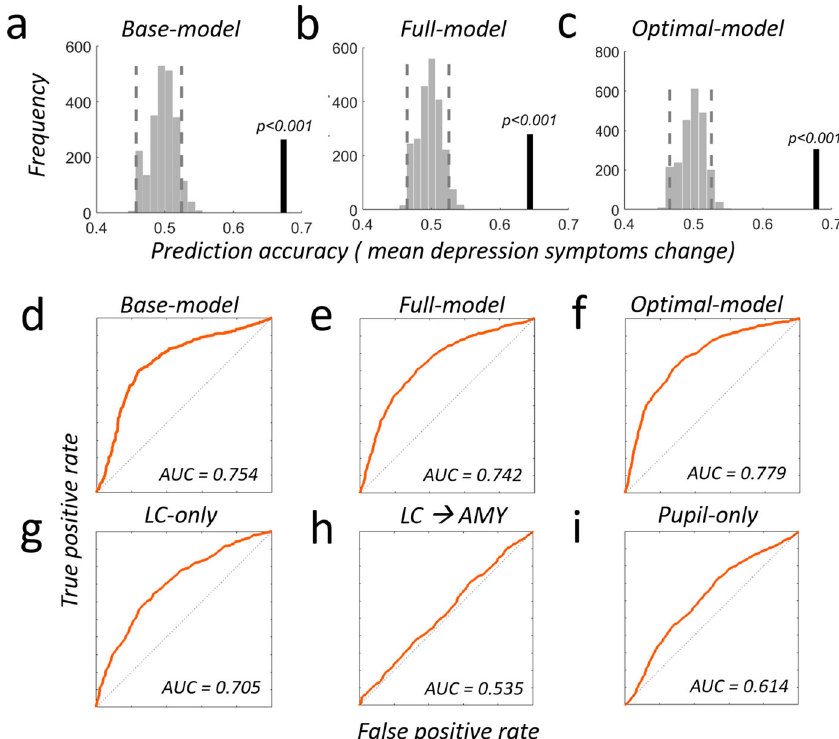
Fig. 9 Comprehensive model comparison for predicting depression-symptom change. a – c Prediction analyses were based on a leave-two-subject-out cross-validation procedure and their signi fi cance was tested using a permutation test with 1,000 permutations for each possible left-out pair combination. a The base-model predicts mean depression symptom increases signi fi cantly above chance (out-of-sample accuracy = 67.38%, p < 0.001, R 2 = 0.27 adjusted R 2 = 0.23). The PHQ-survey score is already a signi fi cant predictor for depression symptom severity changes ( p = 0.0002). b The full model containing additional behavioral-, neural- and pupil data predicts mean depression increases signi fi cantly above chance (out-of-sample accuracy = 64.36%, p < 0.001, R 2 = 0.37, adjusted R 2 = 0.28) and increases the explained variance by 11% and the adjusted explained variance by 4.3%. c The optimal model has similar prediction improvements as the full model (out-of-sample accuracy = 67.7%, p < 0.001, R 2 = 0.33, adjusted R 2 = 0.30) but contains only two parameters: locus coeruleus upregulation response ( p = 0.039) and the PHQ-depression survey ( p = 0.0009). Compared to the base-model, this sparse model predicts 10% more of the variance and also 10% of the adjusted variance. d – i Receiver operating characteristic (ROC) plots and area under the curve (AUC) for different combinations of measures predicting depression: ( d ) Base-model, ( e ) Full-model, ( f ) Optimal model, ( g ) LC-only, ( h ) LC- Amygdala only, ( i ) pupil only. Please see Supplemental Table S8 for additional models, full details on single regressor contributions and model comparison. Source data are provided as a Source Data fi